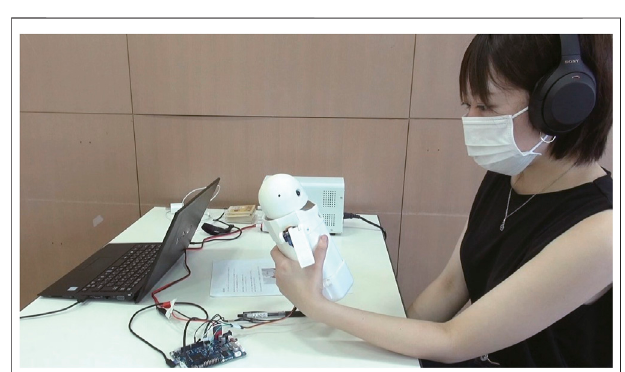
OMOYandtestedoneofitsbehaviorsgeneratedbyspeechandweightshifts. An experimenter took a seat in front of the